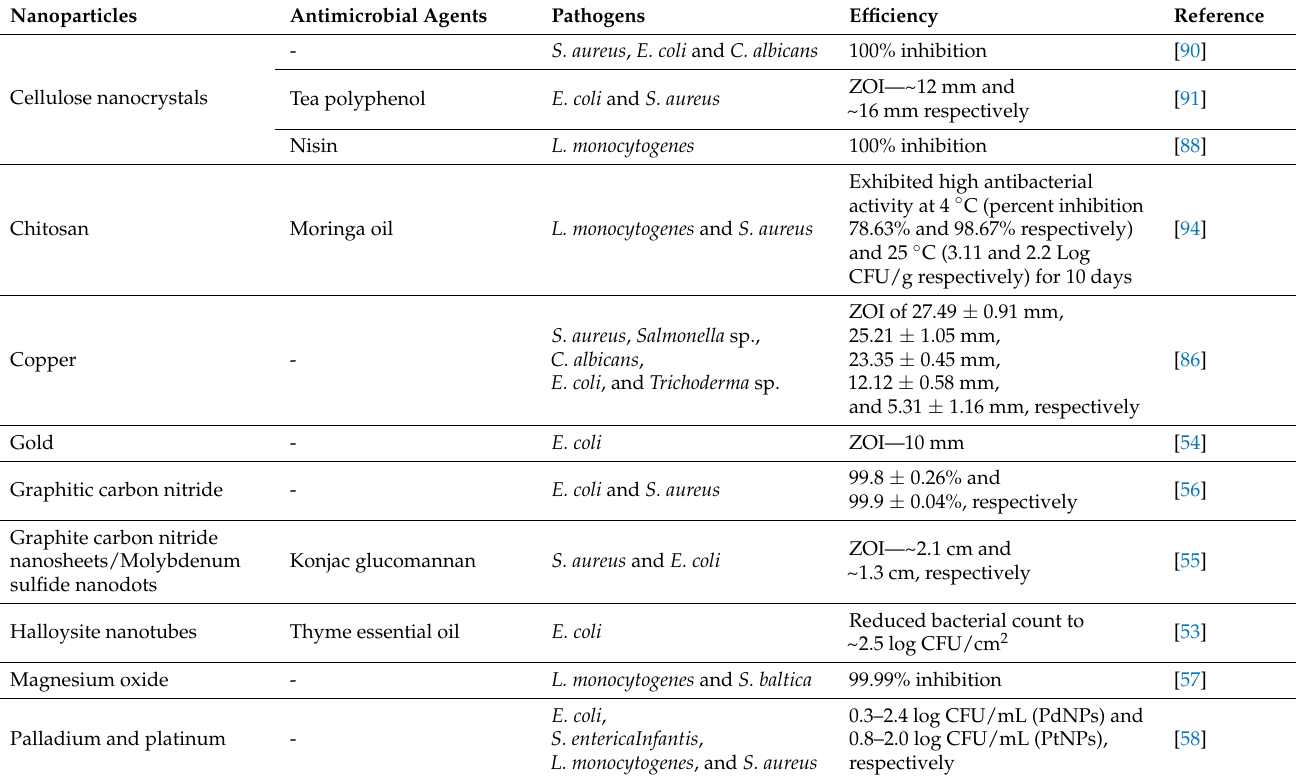
Table 2. Antimicrobial nanoparticles against foodborne